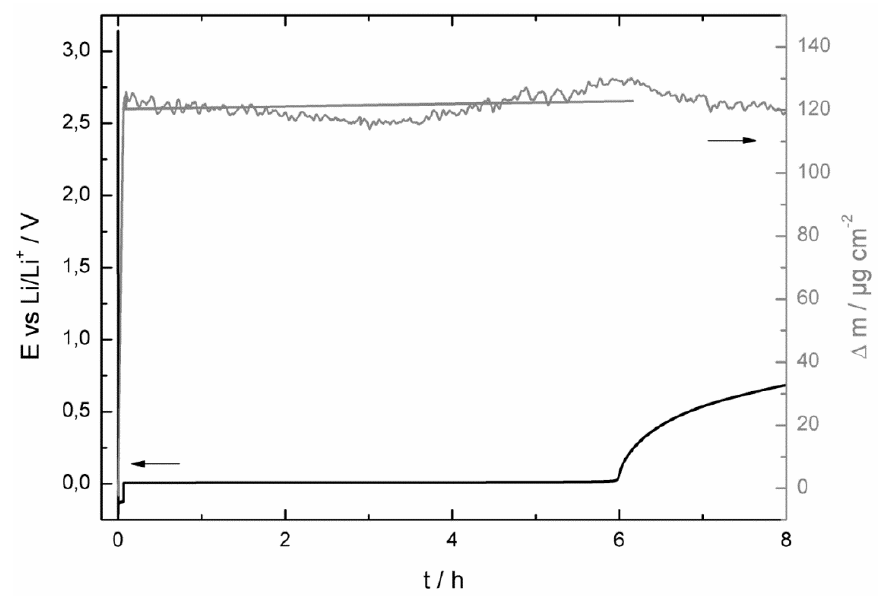
Figure 9. Time dependence of potential and attributed mass change during the first 8 h of the OCP measurement after lithium was deposited onto copper from 1 M LiDFOB in EC:DEC (3:7, by wt.).